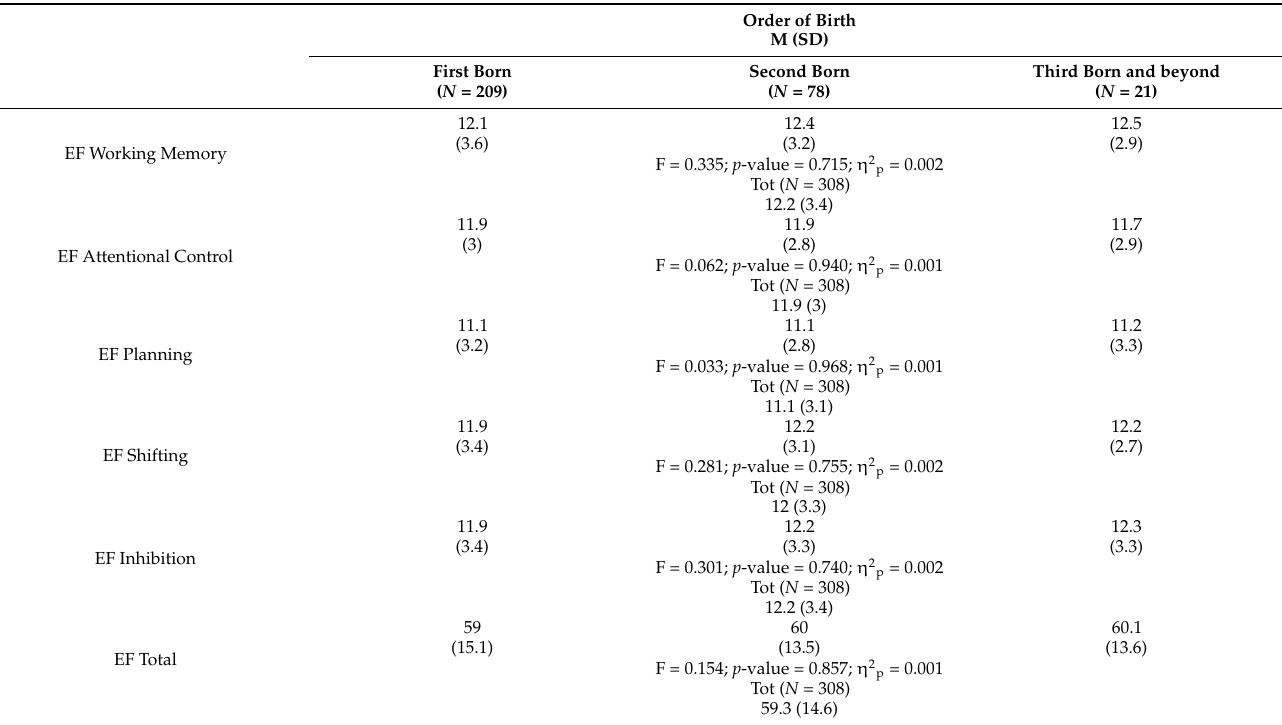
Table 11. EF descriptive data and ANOVA analyses for order of birth.